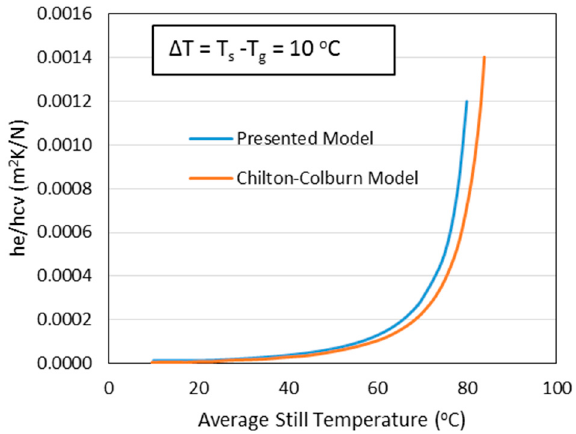
Energies 2019 , 12 , x FOR PEER REVIEW Figure 5. he/hcv corresponding to Chilton-Colburn model. Figure 5. he/hcv corresponding to Chilton-Colburn model.